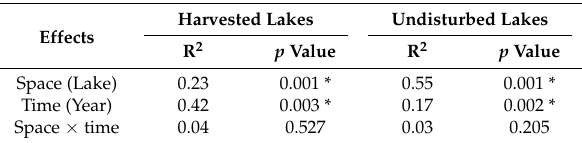
Table 3. Effect of time, space and their interaction on zooplankton abundance in the two groups of lakes (harvested vs undisturbed). Values are significant at p ≤ 0.05. All tests were performed with 999 permutations. * significant